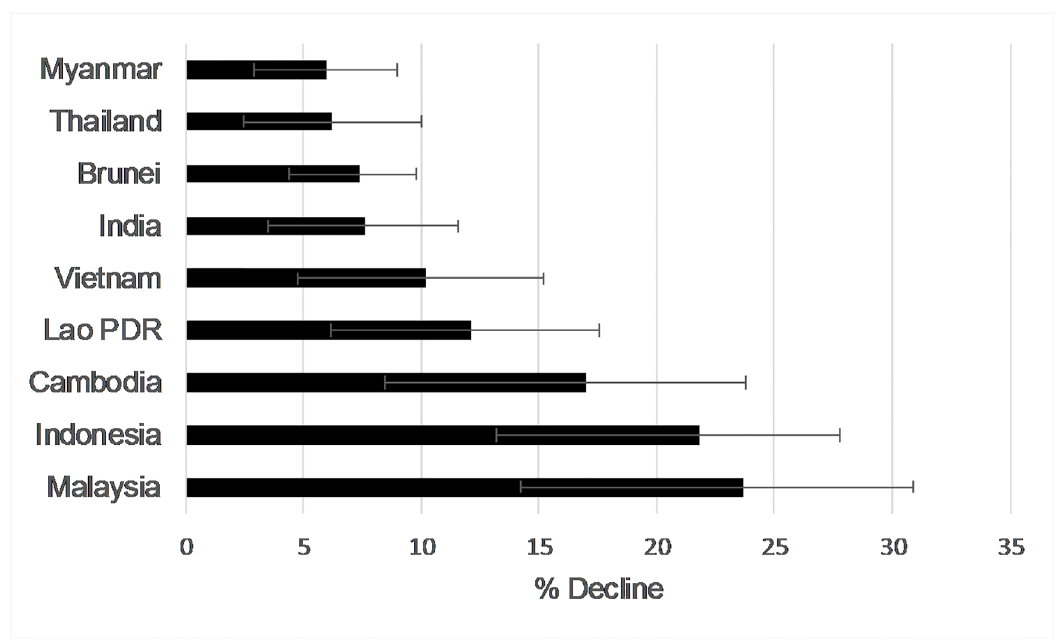
Fig 4. Model-based projections of sun bear population change across southeast Asia between 2000–2014. Bars, with 95% confidenceintervals, show estimates generatedby binary regression models (Eq 2) fit to the pooledmainland and insulardata. Models assumed log catch rate of sun bears at camera traps was a linear function of % tree cover averaged over a 6 km 2 circular area aroundcamera traps. Country-level declineswere predictedto be the most severe in Malaysia and Indonesia,which form the bulk of the insular region. On the mainland, declinesroughlyfollow a longitudinal gradient,being highest in eastern countries (Cambodia, Lao PRD, Vietnam) and lowest in the west (India, Thailand,